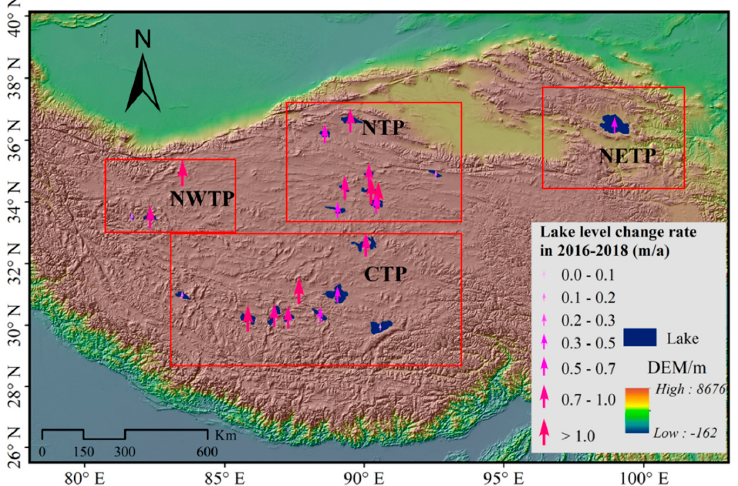
Figure 7. Spatial distribution of lake level changing rates in the Tibetan Plateau during 2016–2018 (red rectangles show the boundaries of different TP regions). NWTP: Northwestern TP, NTP: Northern TP, NETP: Northeastern TP, and CTP: Central TP. Table 3. Statistics of lake level changing rates in the Tibetan Plateau from 2016 to 2018 (“Y” represents terminal lakes and “N” open lakes).